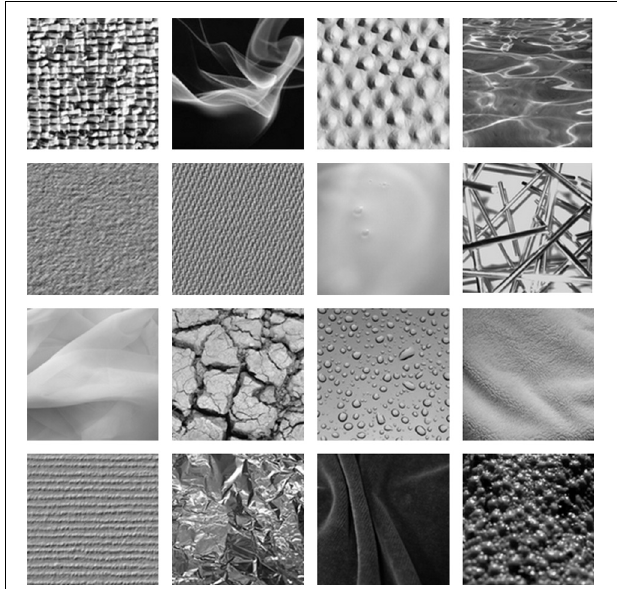
FIGURE 1 | Sixteen textures used in the response